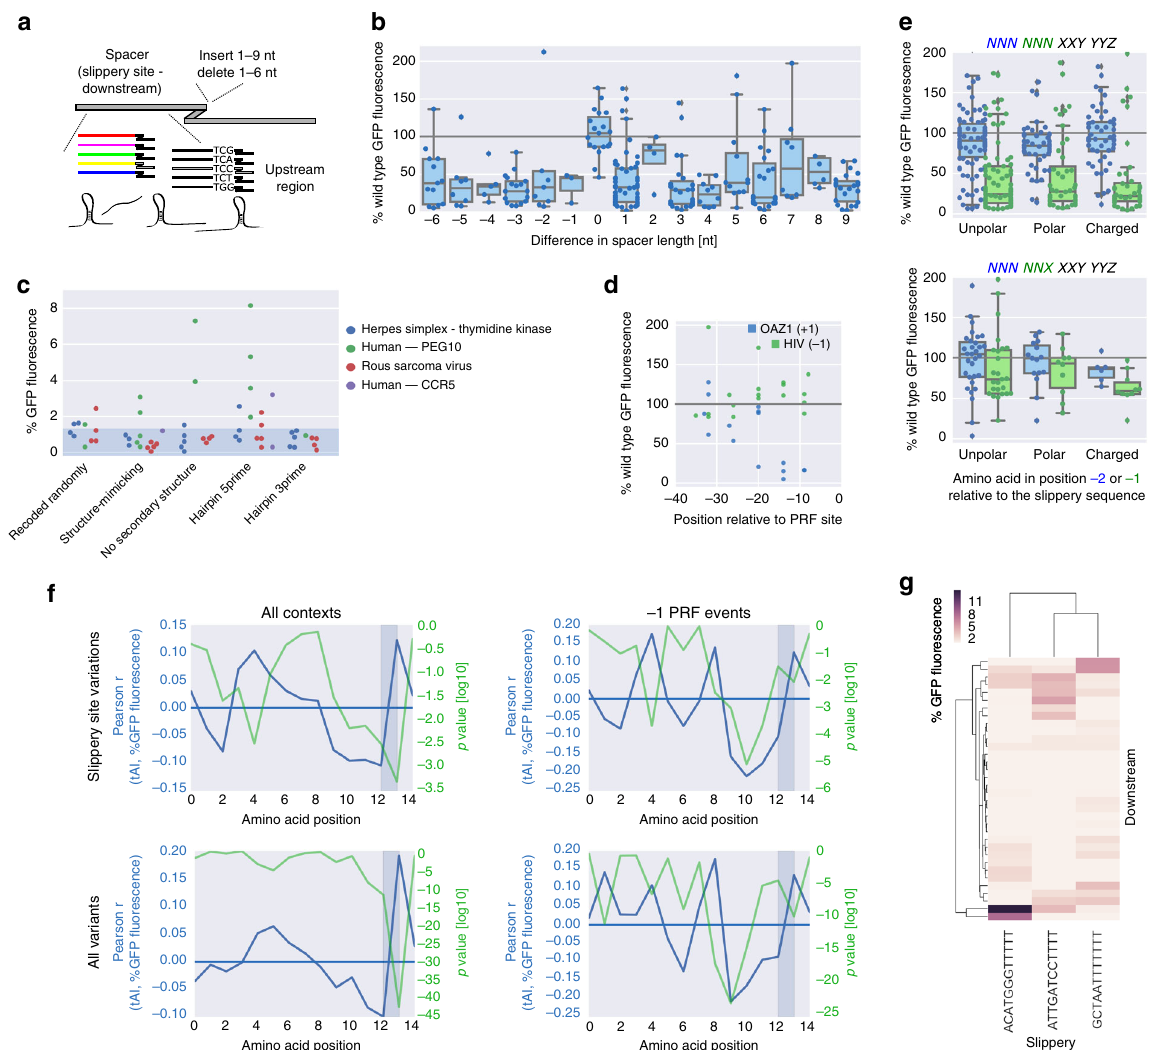
Fig. 5 Additional regulatory elements contribute to PRF. a Schematic of sequence manipulations upstream and immediately downstream of the slippery site. b Boxplots of % wild-type frameshifting rates for variants of − 1 PRF sites, in which the indicated number of nucleotides were deleted (negative numbers) or inserted (positive numbers, taken from two different constant sequences) after the slippery site; the box shows the quartiles of the dataset, while the whiskers show the rest of the distribution except for outliers; n = 13, 7, 4, 17, 7, 3, 16, 54, 4, 27, 10, 12, 23, 8, 6, and 23 sequences tested, in the order they appear on the graph. c % GFP fl uorescence for variants of − 1 PRF sites with the sequence upstream of the slippery site being randomly recoded or replaced with sequences predicted to have the indicated secondary structure; the shaded area denotes the range of background fl uorescence. d % wild- type frameshifting rates ( + 1 for OAZ, blue, and − 1 for HIV, green) of variants, in which the native upstream region has been replaced by constant sequences up to the indicated position relative to the PRF site. e Boxplot of percent of wild-type frameshifting rates for variants, in which the − 2 or − 1 amino acid relative to the slippery site is replaced with an amino acid from the indicated groups, for codons which would maintain the slippery site pattern XXXYYYZ (bottom) or not (top); the box shows the quartiles of the dataset, while the whiskers show the rest of the distribution except for outliers; n = 95/79, 43/39, 47/37 and 31/25, 16/10, 6/10 sequences tested. f Pearson correlation coef fi cient (blue) and associated two-tailed p -values (green) between tAI at the indicated position of the original reading frame and % GFP fl uorescence. g Clustered heat map showing all possible combinations of 3 synthetic slippery sites, 34 synthetic downstream variants, and up to 5 synthetic upstream regions (minimal value